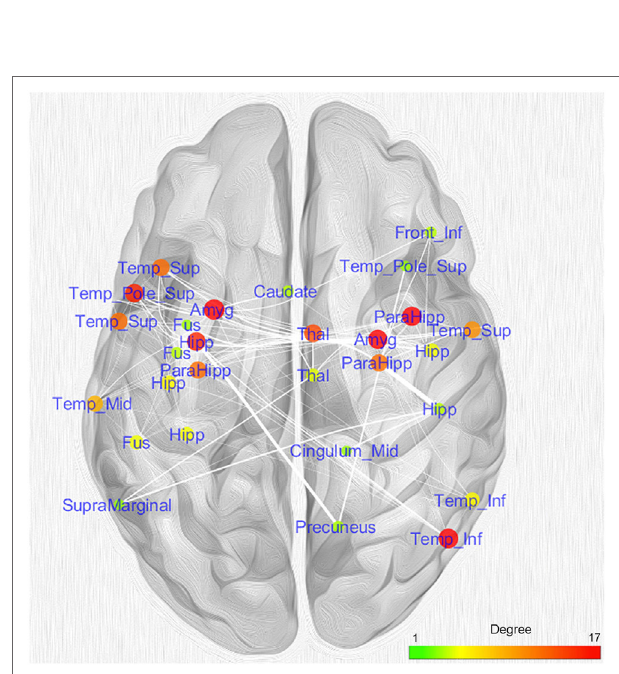
FigUre 5 | Topological analysis of the coatrophy network of Alzheimer’s disease. Nodes referring to the same brain areas or strictly close one to the other have been collapsed in a single